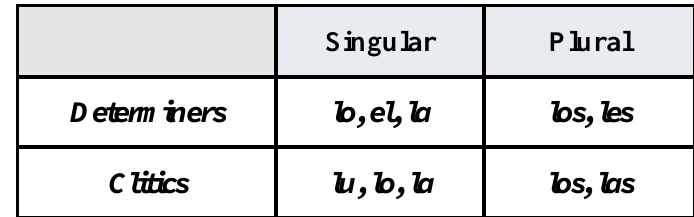
Table 2. Morphological forms of clitics and determiners in